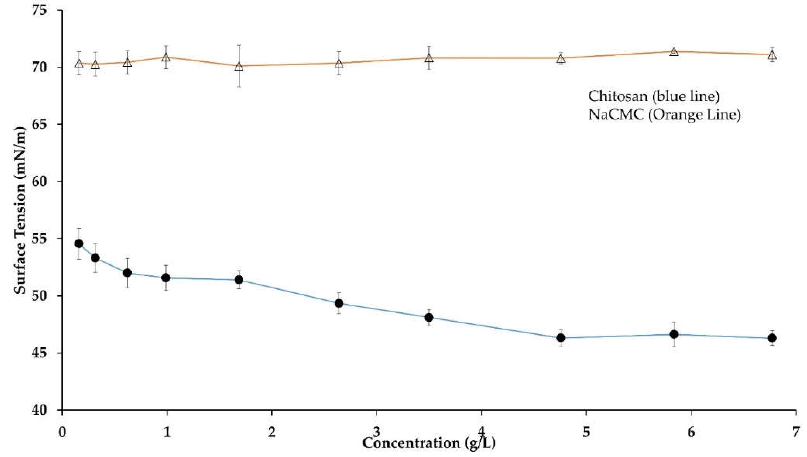
Figure 2. Surface tension of aqueous CH and NaCMC at pH 5.5 and 40 °C. Mean values with 95% confidence interval.